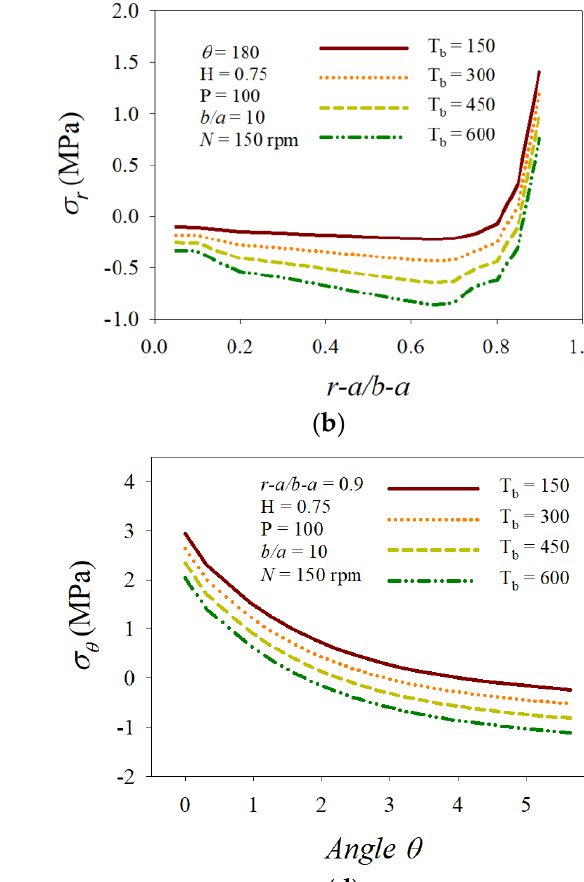
Figure 4. Effects of outer boundary temperature on the components of displacement: ( a ) Radial at θ = 0 , ( b ) radial at θ = 180 , ( c ) circumferential at (r − a)/(b − a) = 0.1, ( d ) circumferential at (r − a)/(b − a) = 0.9.